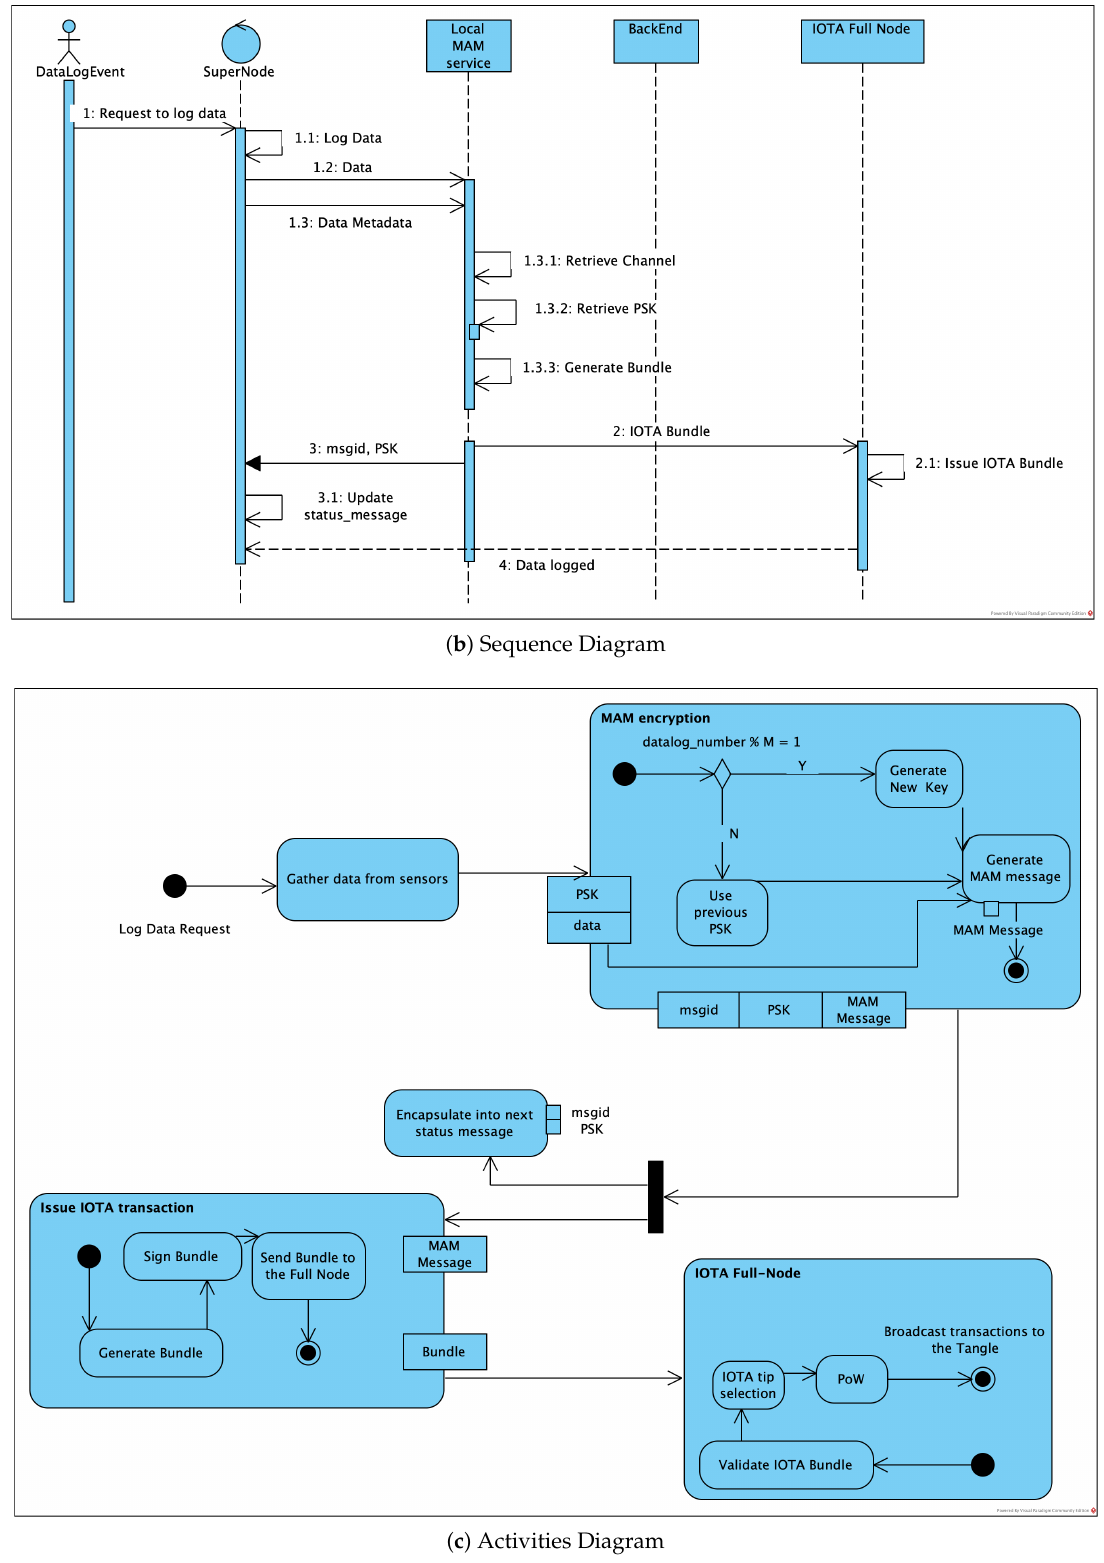
Figure 12. UML diagrams regarding the data log